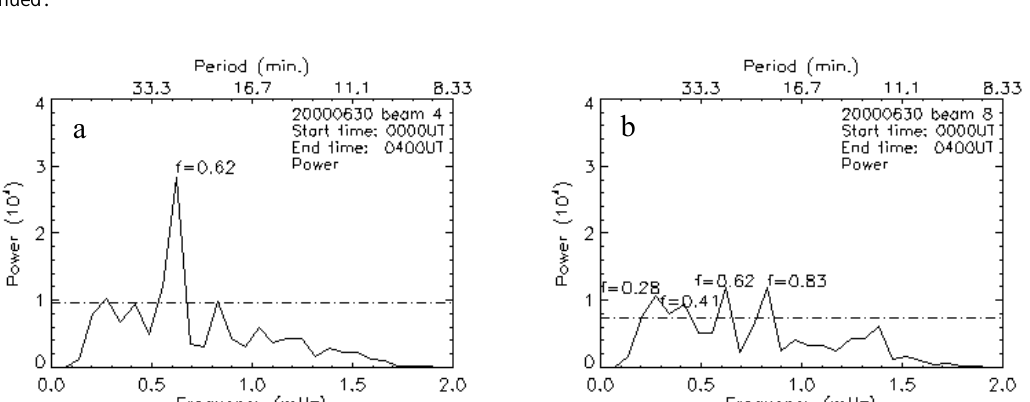
Fig. 6. The averaged power spectra of the fluctuations of sea scatter powers during the interval of 00:00 UT to 04:00 UT, on 30 June 2000 along beam 4 (a) and beam 8 (b) . The dotted line indicates the mean power level of the TIDs’ significant frequencies from 0.83mHz (20min) to 0.33mHz